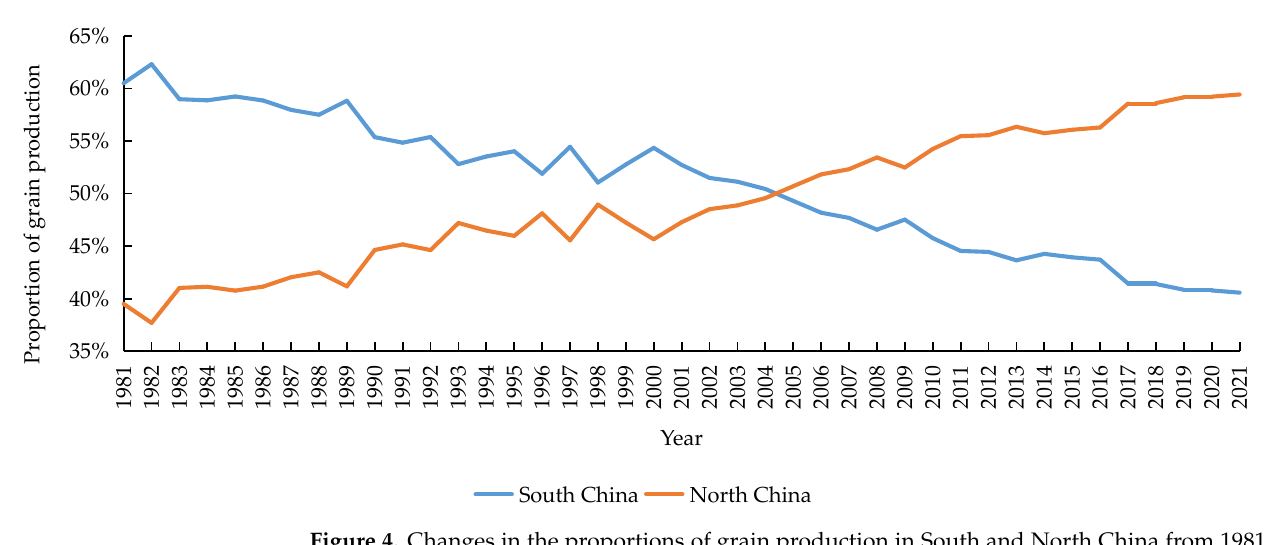
Figure 4. Changes in the proportions of grain production in South and North China from 1981 to 2021 [51].